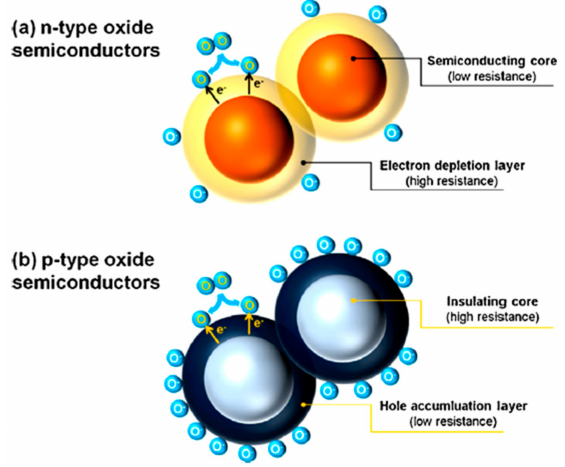
Figure 4. The electronic core-shell structures formation in metal oxide semiconductors: ( a ) n-type; ( b ) p-type. Reprinted from Ref. [78] with permission of Sensors & Actuators: B. Chemical, 2014. The gas sensing behavior of n-type and p-type MOS are different in function of the target gases, as listed in Table 3 [79]. Table 3. The gas-sensing performance of n-type and p-type MOS towards reducing and oxidizing gases.